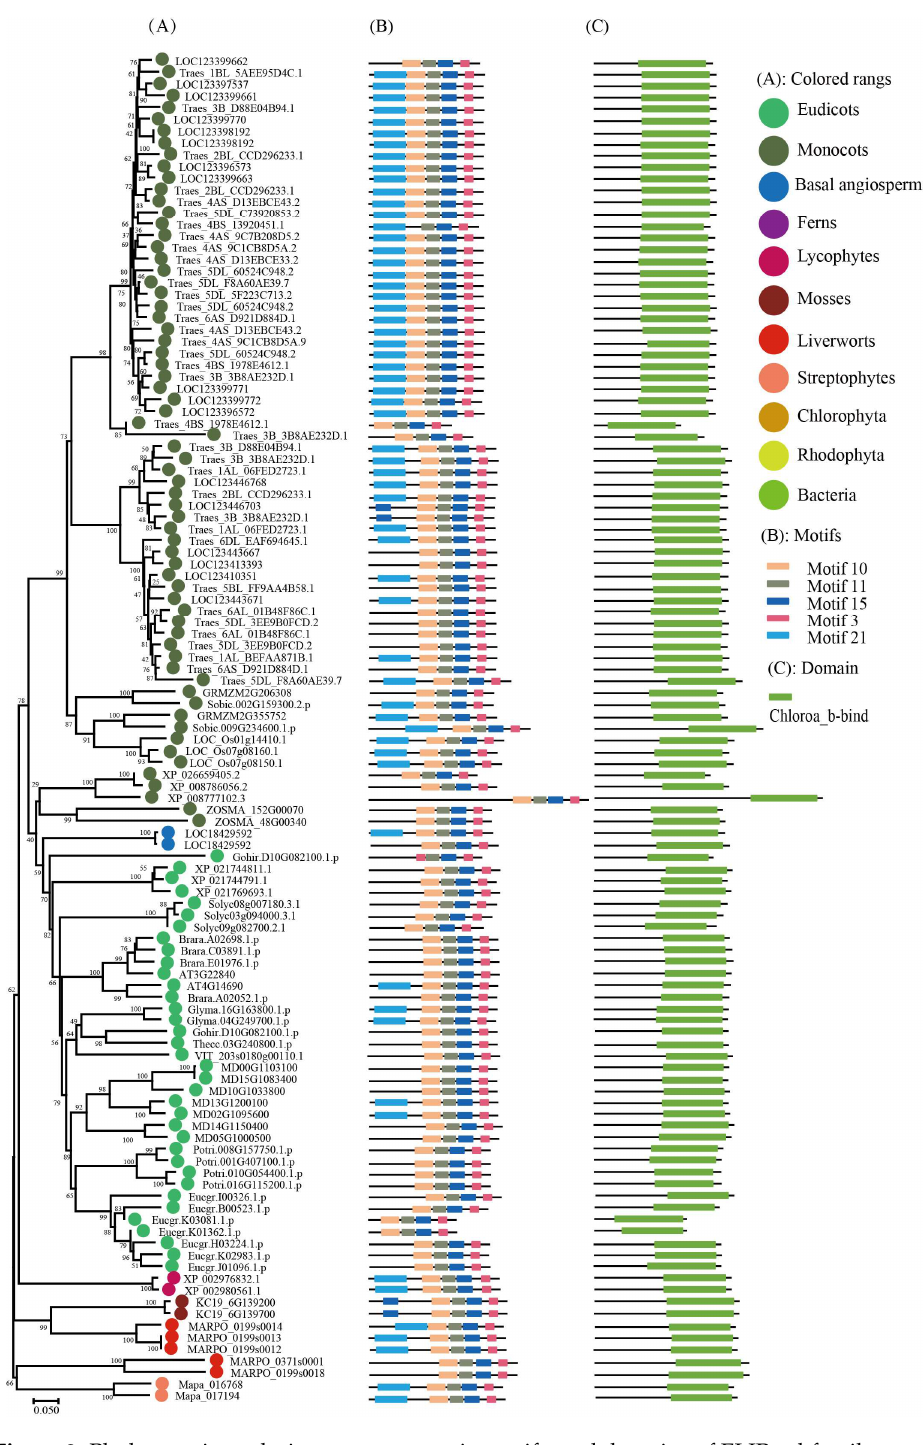
Figure 2. Phylogenetic evolutionary tree, protein motifs, and domains of ELIP subfamily members: ( A ) Unrooted phylogenetic tree of the ELIP subfamily; ( B ) motifs of the ELIP proteins. The different colors indicate five motifs (left panel); ( C ) protein domains of the ELIP genes.